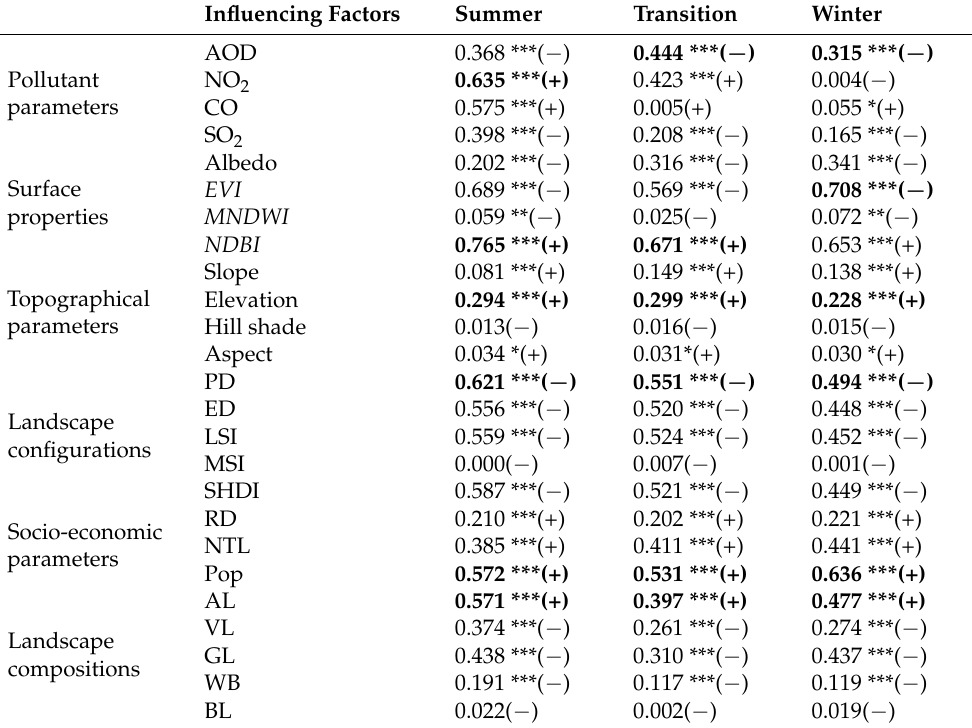
Table 6. R-squared of ordinary least square regression (OLS) for influencing factors affecting